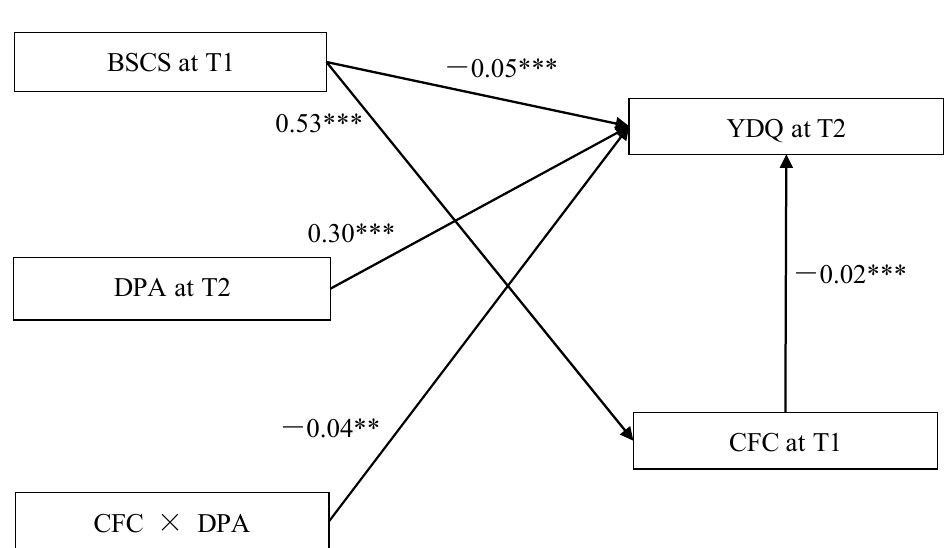
Figure 2. Model of the moderating role of DPA in the indirect relation between BSCS and YDQ. Note: ** p < 0.01, *** p < 0.001. BSCS = Brief Self-Control Scale, CFC = Consideration of Future Consequences Scale, DPA = Deviant Peer Affiliations Scale, YDQ = Young’s Diagnostic Questionnaire. Covariates including sex, home residence, and the education level of parents.